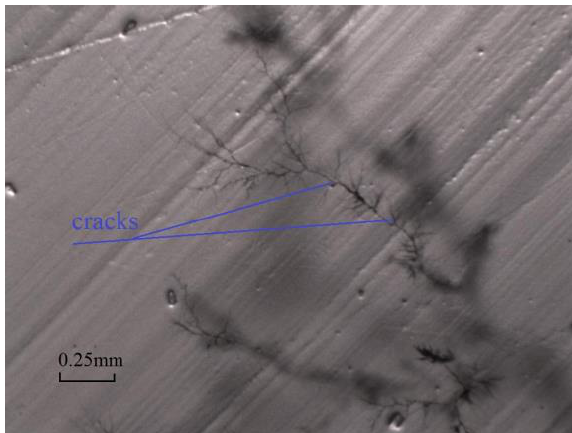
Figure 8. Electrical-tree propagation along the crack in interface region of XLPE EMJ.